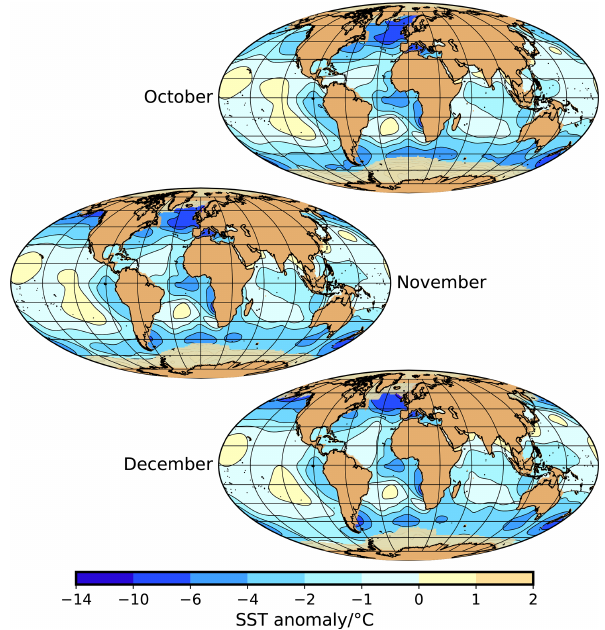
Figure A8. Sea-surface temperature anomaly (contour map) and sea-ice extent (yellow–brownish areas close to Antarctica and in the Arctic) for October, November, and December.